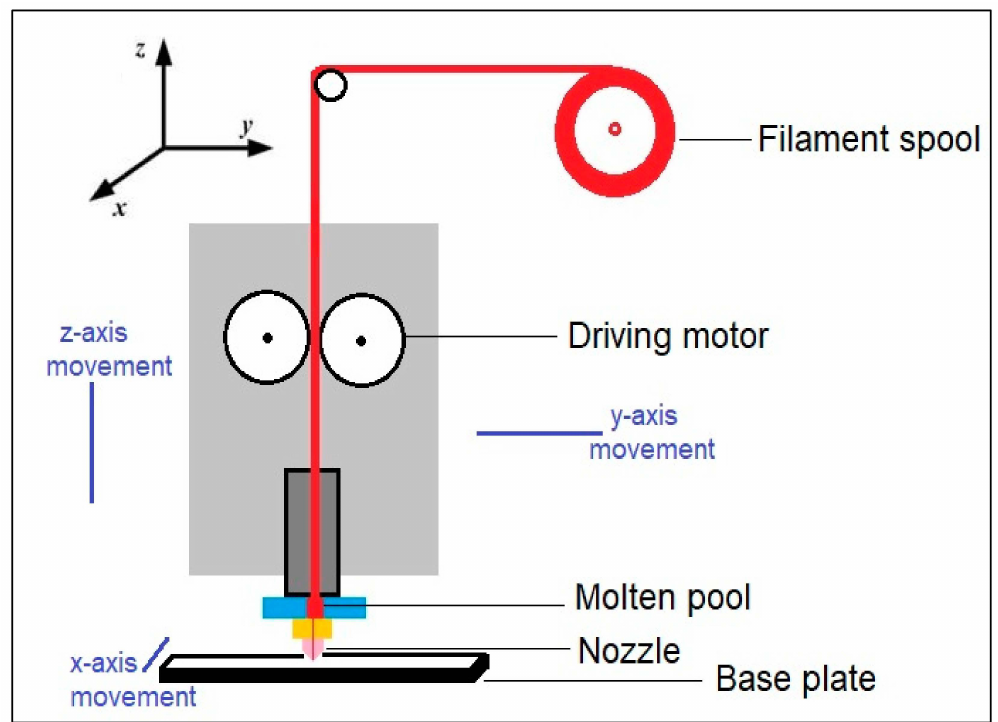
Figure 2. Schematic of fused deposition modeling